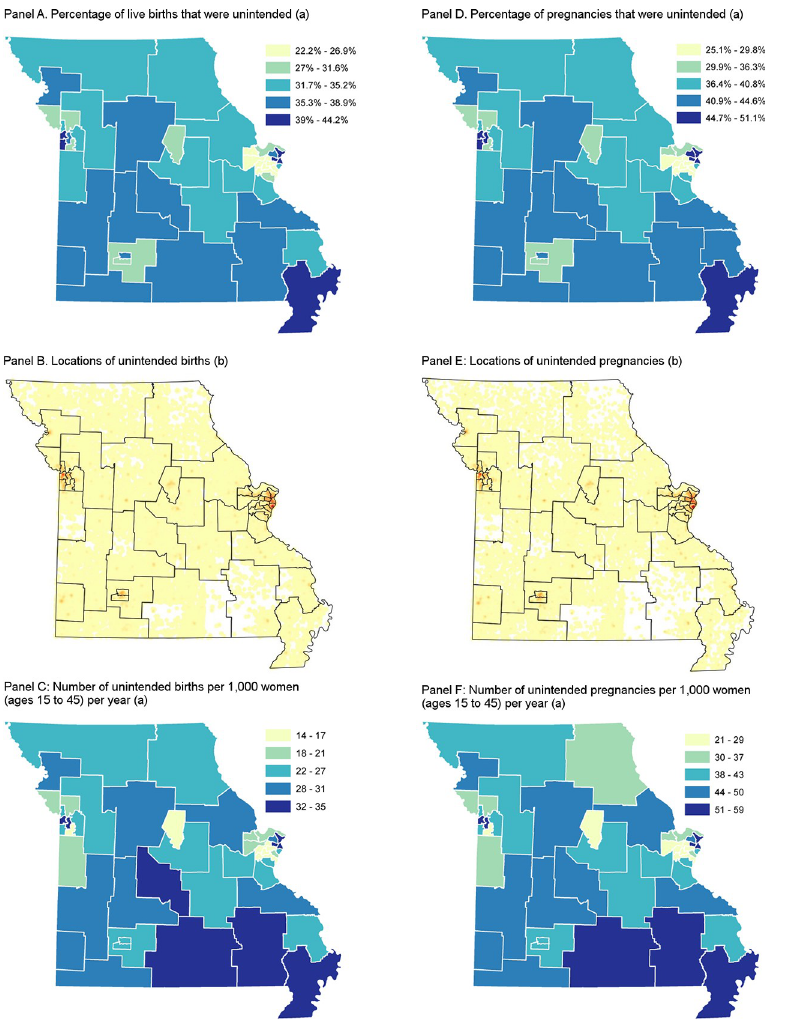
Fig 3. Unintended births and pregnancies (estimated) in Missouri, by region, 2014 to 2016.